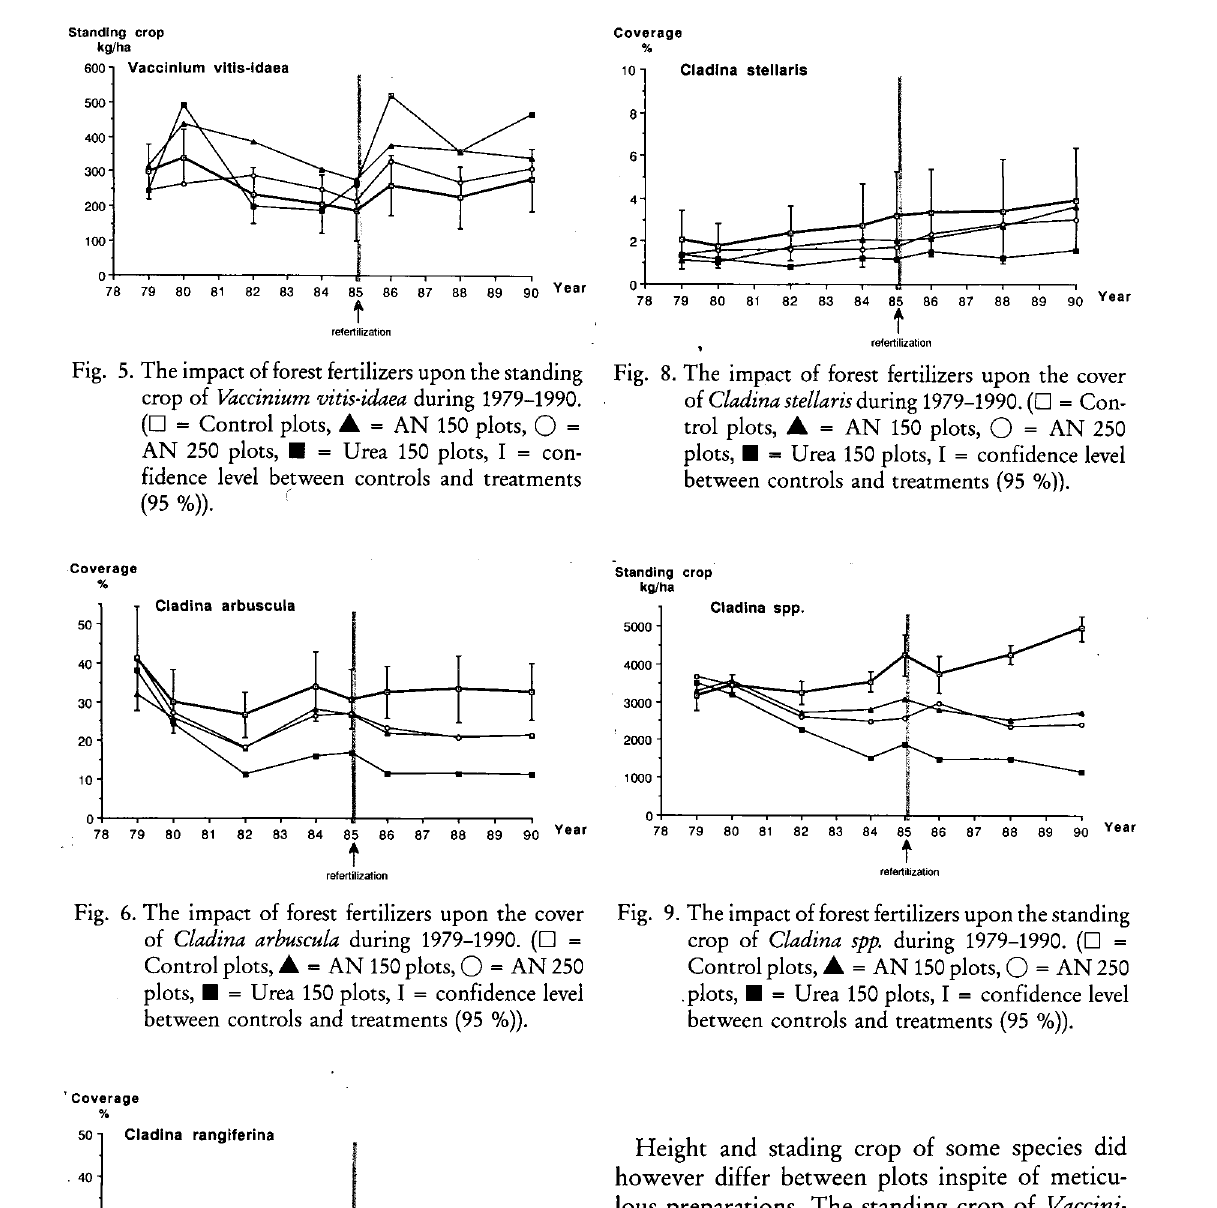
Fig. 7. The impact of forest fertilizers upon the cover of Cladina rangiferina during 1979-1990. (• = Control plots, A = AN 150 plots, O = AN 250 plots, • = Urea 150 plots, I = confidence level between controls and treatments (95